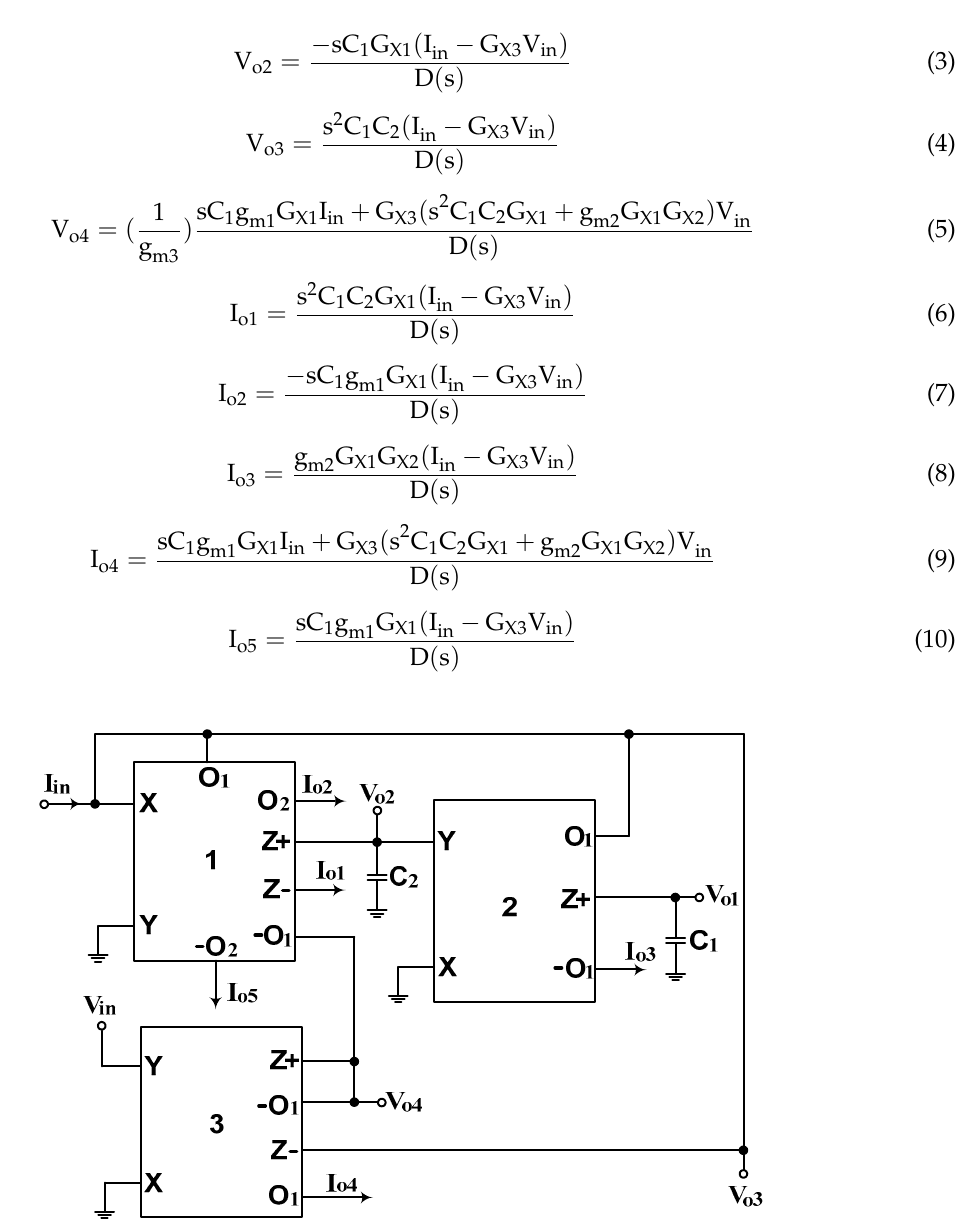
Figure 2. Proposed electronically tunable mixed-mode biquadratic filter.